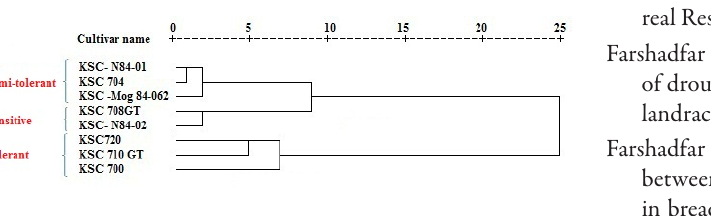
Fig. 2. Dendrogram using Ward method between groups show- ing classification of cultivars based on